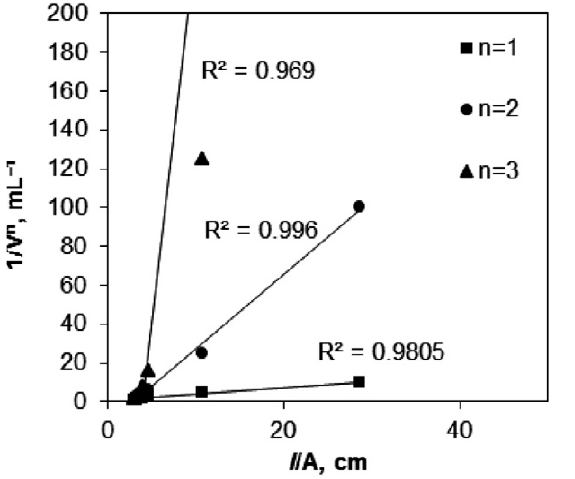
Figure 6. Determination of the molar ratio (n) Mo(VI):TTC by the method of continuous variations C Mo(VI) + C TTC = 8.0 × 10 −5 mol L –1 ; C 3,5-DNC = 1.2 × 10 –3 mol L –1 ; C H2SO4 = 4.5 × 10 –1 mol L –1 ; λ = 410 nm; τ = 3